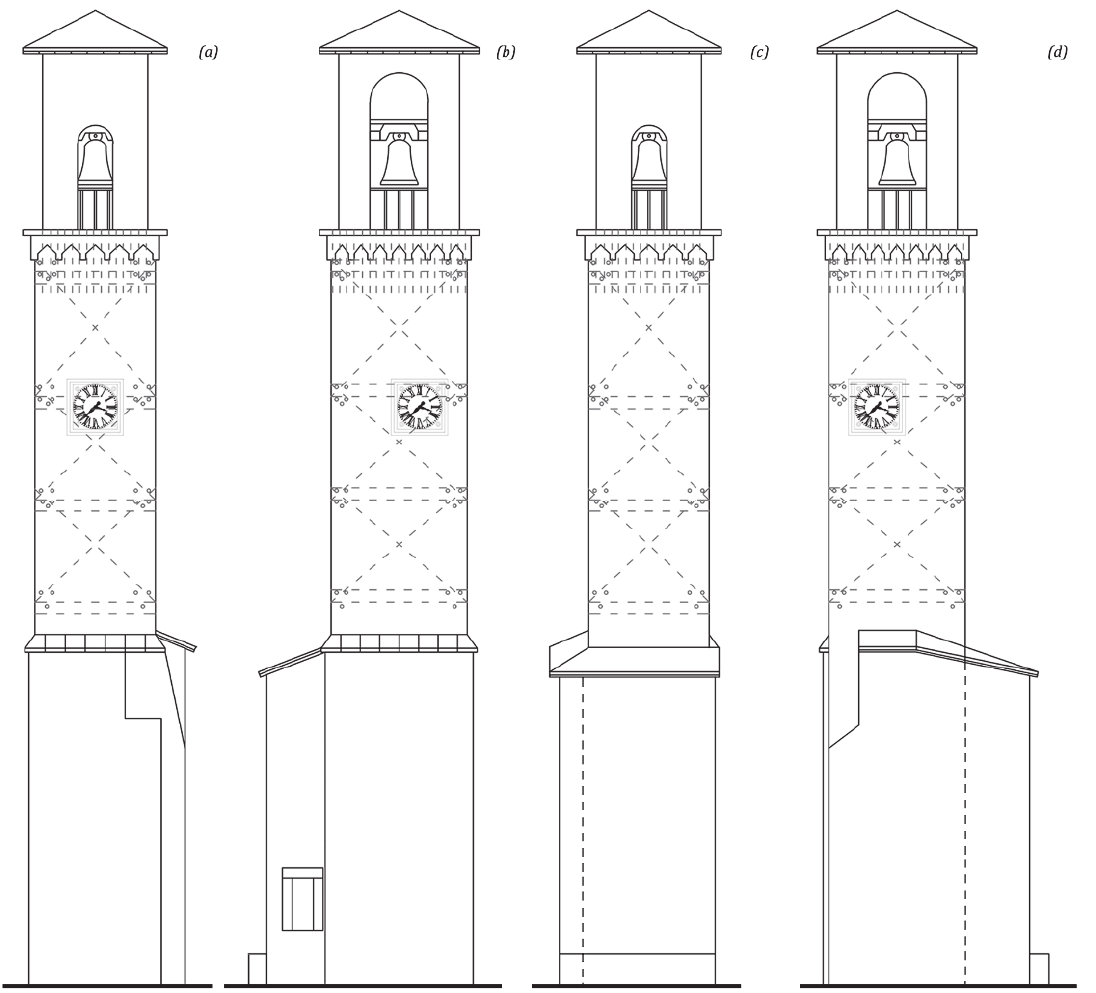
Figure 3: Drawings of the consolidation of the North façade (a), East façade (b), South façade (c), West façade (d) of the Amatrice civic clock tower of the